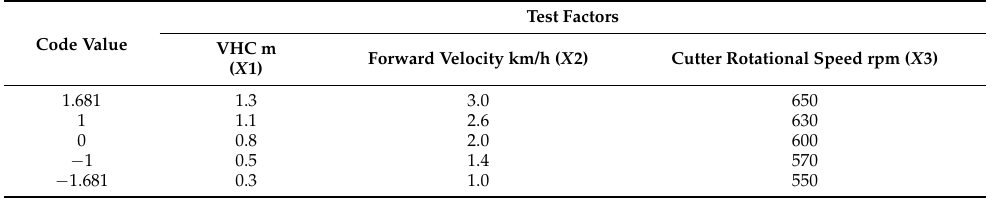
Table 1. Test factor level coding table.